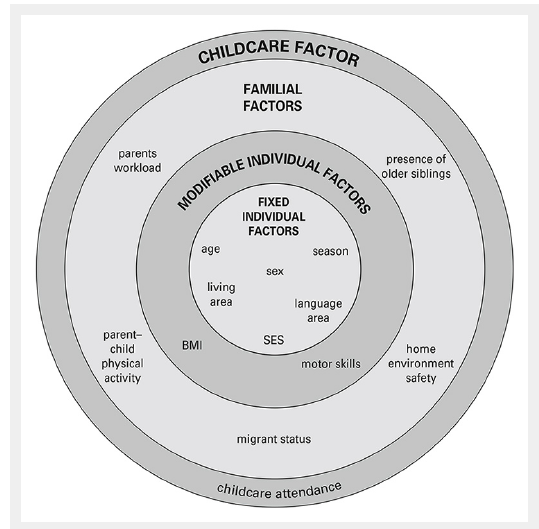
Based on the socioecological model potential correlates of physical activity and sedentary behaviour were grouped in different sets and added stepwise in the analysis. Model 1 included the core correlates with fixed individual factors,